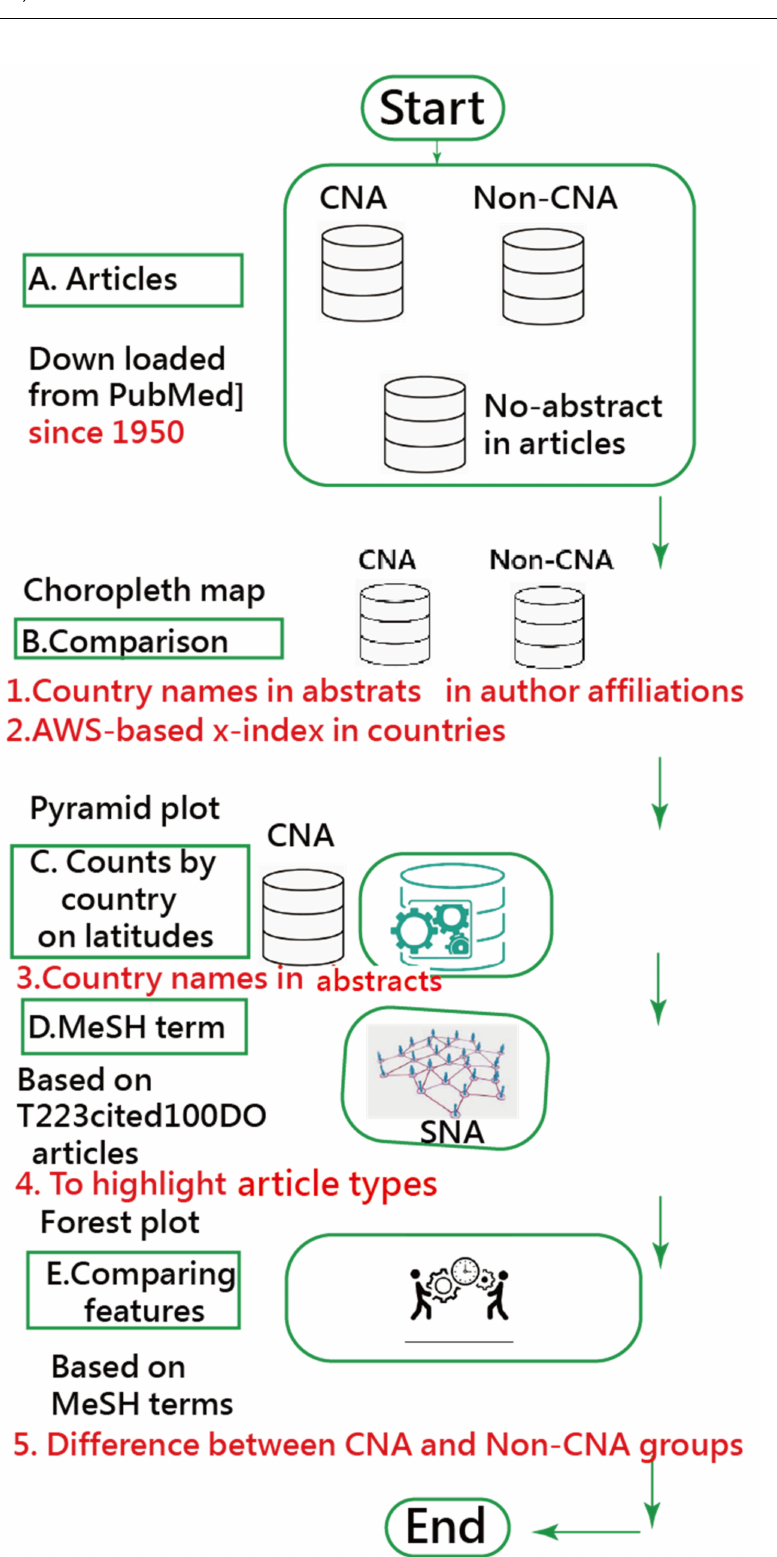
Figure 1. The study flowchart and contents. CNA, abstracts that included country names; Non-CNA, abstracts without country names; AWS, author-weighted scheme; SNA, social network